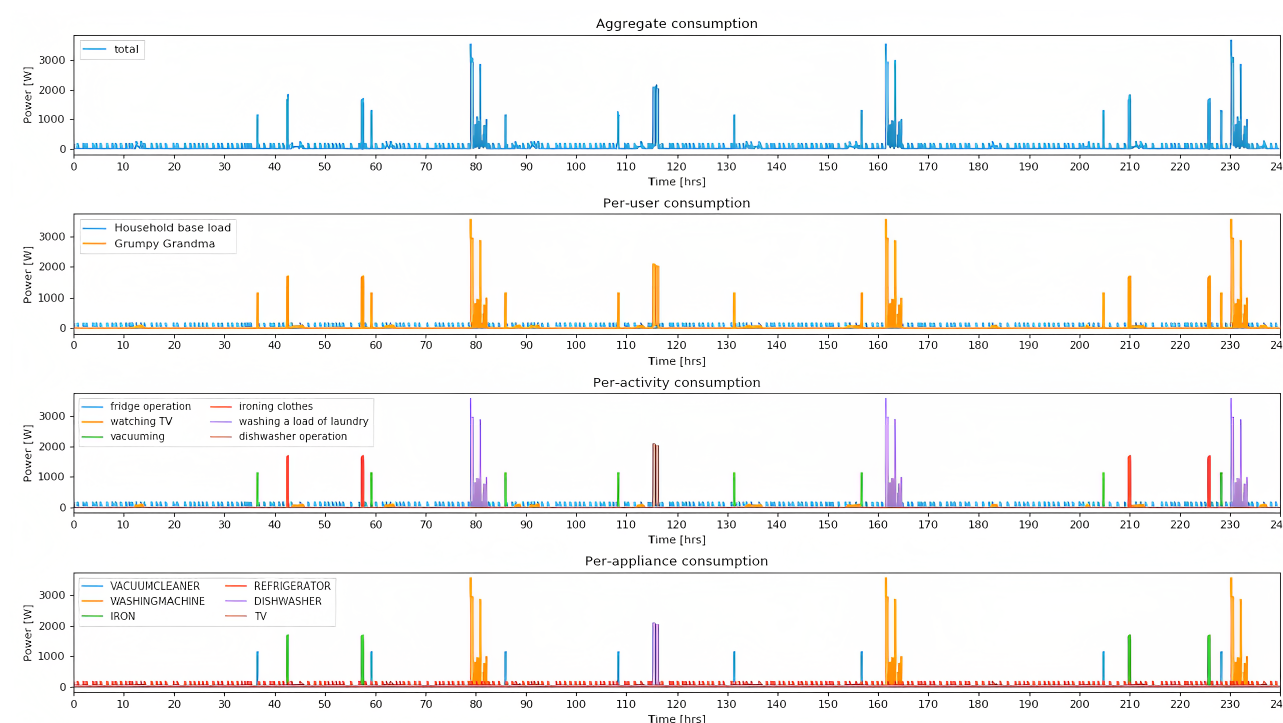
Figure 3. Consumption profile of a house generated by ANTGen for one